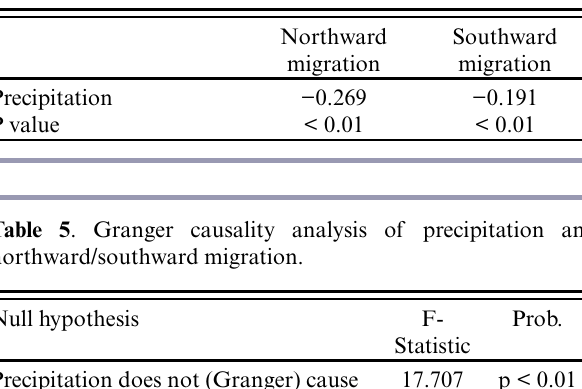
Table 4 . Correlation analysis of precipitation and northward/ southward migration.